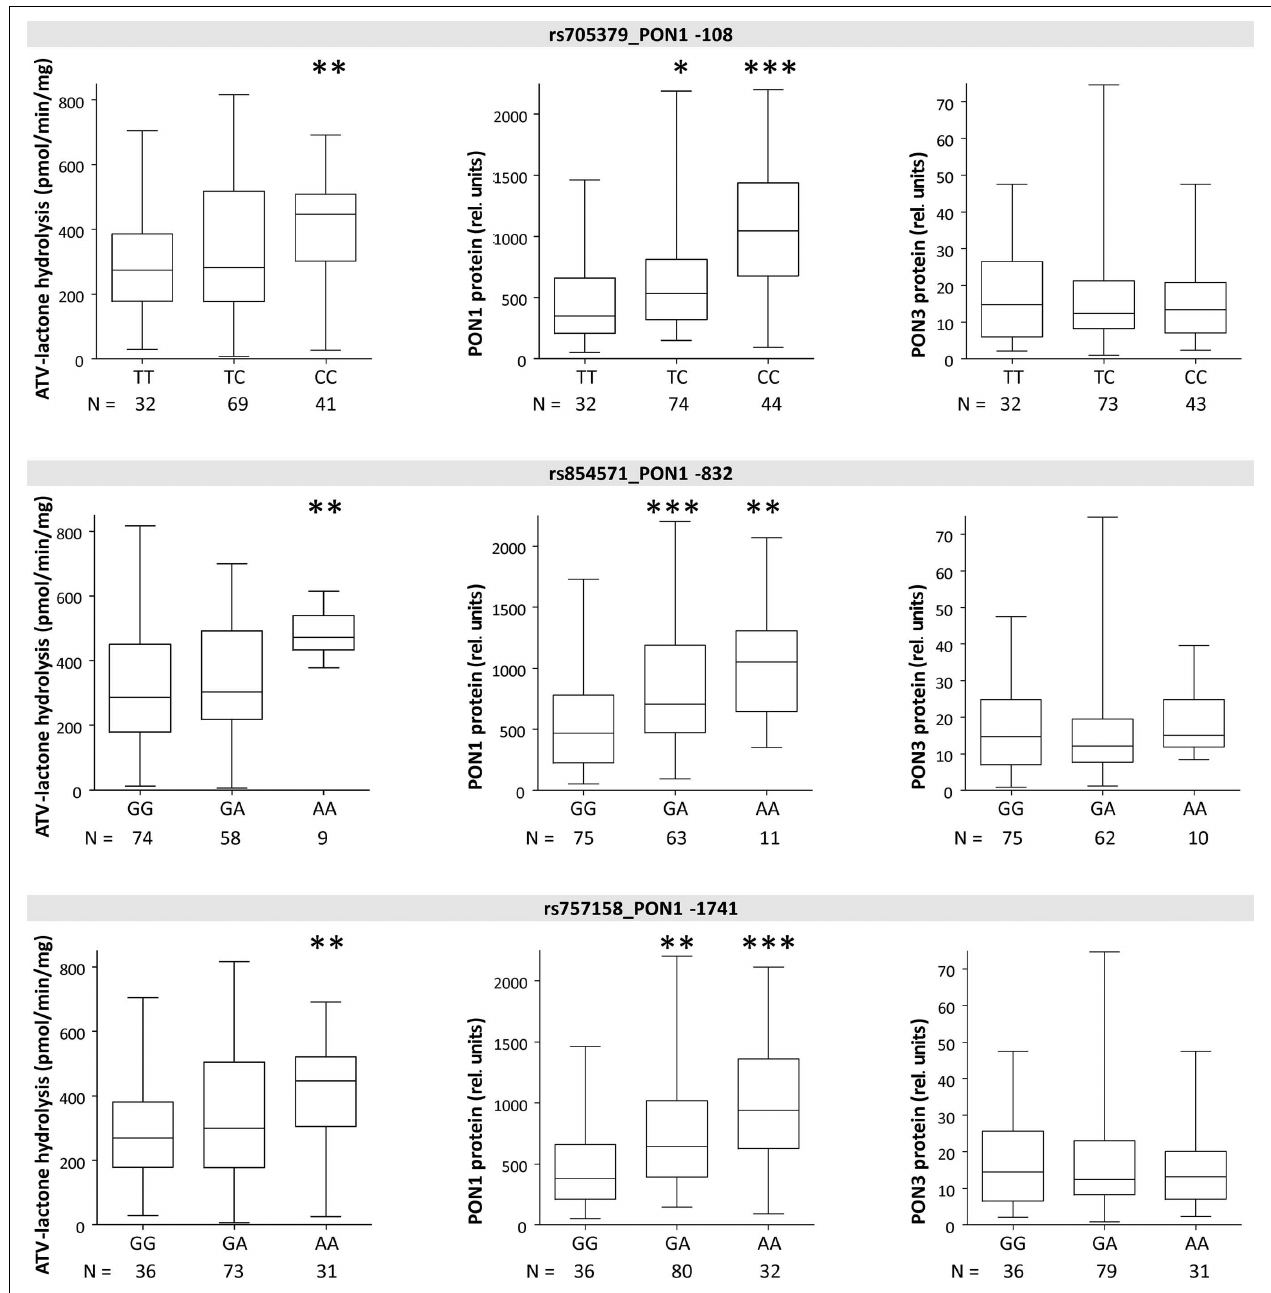
are compared with homozygotes of reference allele byWilcoxon–Mann– Whitney-tests significance levels are indicated for P < 0.05 (*), P < 0.01 (**), and P < 0.001